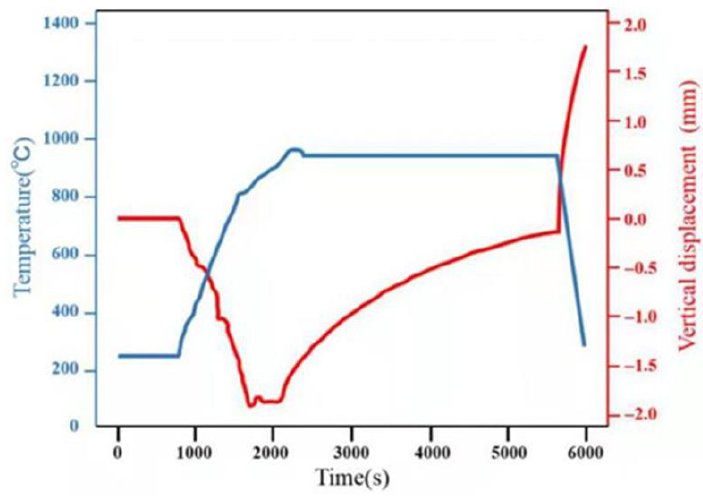
Figure 3. Real-time welding process monitoring curve.